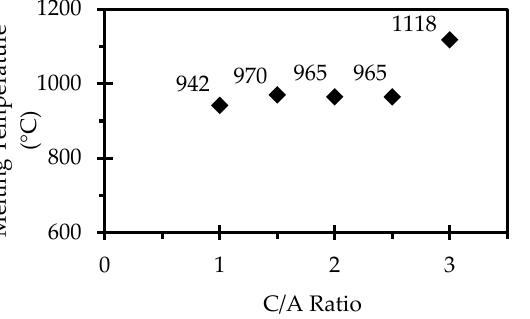
Figure 13. Effect of C/A ratio on the melting temperature of C-series mould powders.